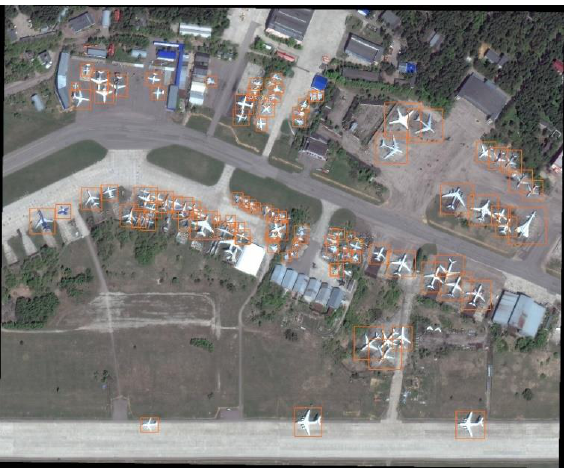
Figure 13. The detection performance for ships with modified Yolov5 in the original satellite image.